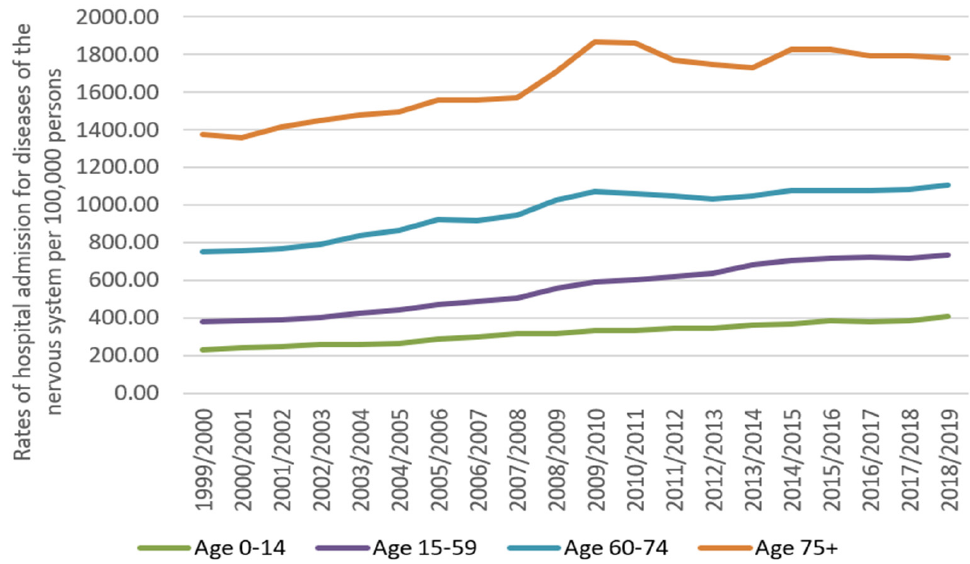
Figure 2. Rates of hospital admission for diseases of the nervous system in England and Wales stratified by age group.